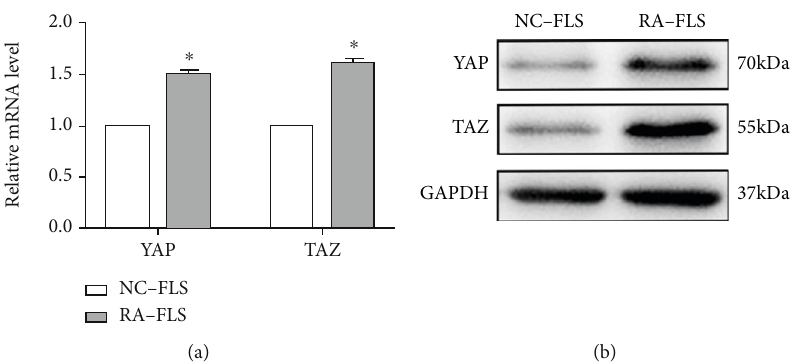
Figure 1: The expression of YAP and TAZ in normal FLS (NC-FLS) and RA-FLS. (a) YAP and TAZ mRNA levels were evaluated from NC- FLS and RA-FLS using RT-qPCR and normalized against GAPDH. Data are the mean ± SD ( n = 4 ). ∗ P < 0 : 05 relative to NC-FLS by Student ’ s t -test. (b) Western blot analysis of TAZ and YAP proteins in NC-FLS and RA-FLS. GAPDH served as loading control. Representative blots are shown ( n = 3 ).